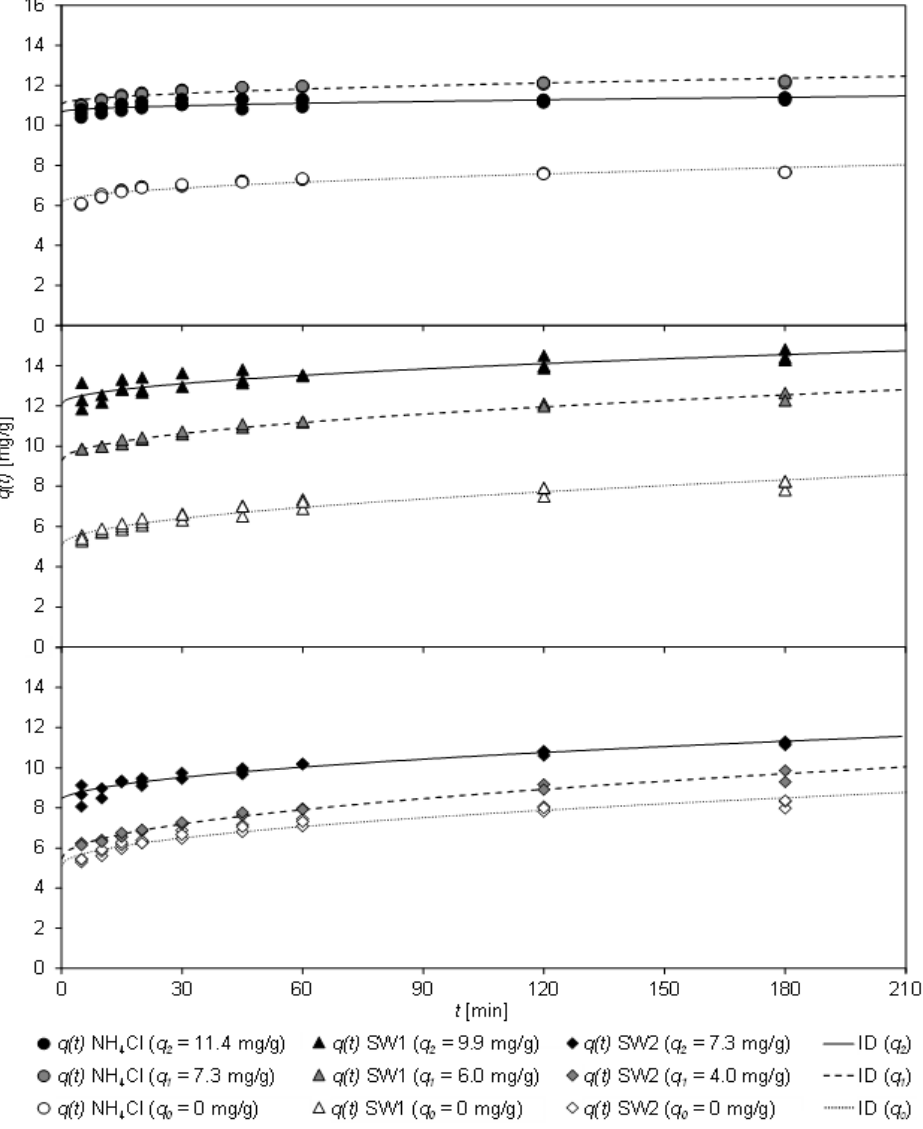
Figure 6. Loading q ( t ) of CCP 20 as a function of the contact time t of differently pre-loaded CCP 20 ( q 0 –q 2 = 0–11.4 mg/g) and fit with the ID model (specific sorbent dosage: 0.1 g CLI /mg NH4-N ; T = 307 K; NH 4 Cl solution: c 0 = 1000 mg/L NH 4 -N; initial pH 5.3; final pH 6.0; SW1: c 0 = 967 mg/L NH 4 -N; initial pH 7.9; final pH 7.6; SW2: c 0 = 775–913 mg/L NH 4 -N; initial pH 7.6; final pH 6.5–8.4).